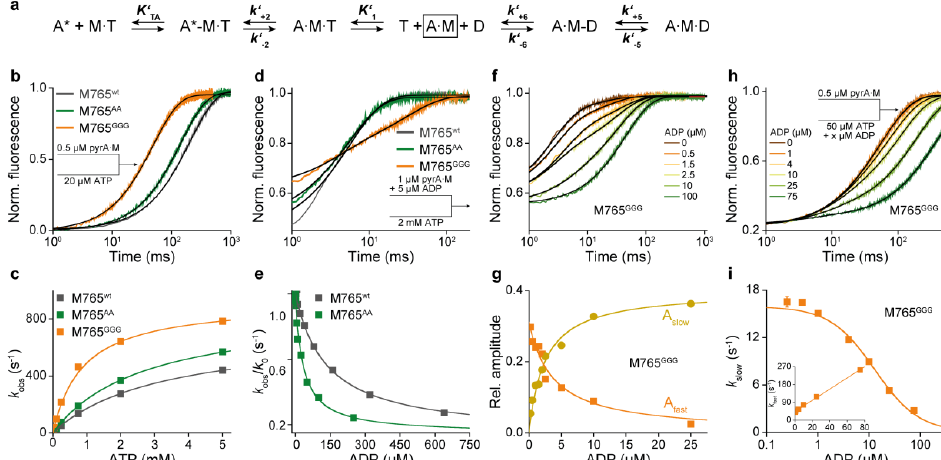
Figure 5. Myosin interactions with nucleotides in the presence of actin. ( a ) Kinetic scheme of the ATP-induced actomyosin dissociation. A*: pyrene-actin fluorescence; A: quenched pyrene-actin fluorescence with bound myosin. ( b ) Normalized fluorescence transients of the dissociation reaction upon mixing a complex of 0.5 µM pyrene-actomyosin (pyrA∙M) with 20 µM ATP. Single exponential fits to the transients yielded concentration-dependent rates ( k obs ) of ATP binding to acto- myosin. ( c ) Second order rate constant of ATP binding to A∙M ( K’ 1 k’ +2 ) and rate of A∙M∙T to A-M∙T isomerization ( k’ +2 ) were obtained from hyperbolic fits of the k obs dependency on ATP. ( d , e ) Affinity of ADP to actomyosin ( K ’ 5 K ’ 6 ) determined by mixing 1 µM pyrA∙M complex in the presence of increasing ADP concentrations with excess ATP. M765 wt and M765 AA displayed monophasic, and M765 GGG biphasic transients shown as exemplary for 2.5 µM ADP ( d ). ( e ) Plots of normalized rate constants ( k obs / k 0 ; with k 0 = dissociation rate constant in the absence of ADP) against ADP concentration. Hyperbolic fits to the data yielded equilibrium dissociation constants of ADP from actomyosin ( K ’ 5 K ’ 6 ). ( f ) For M765 GGG , ATP-induced complex dissociation in the presence of increasing amounts of ADP could be fitted by double exponentials. ( g ) Reciprocal hyperbolic dependency of the relative amplitudes for the fast phase (A fast ) and the slow phase (A slow ) reveal the affinity of ADP for A∙M765 GGG . ( h , i ) Competitive binding of ATP and ADP to A∙M765 GGG . ( h ) Fluorescence transients upon mixing 0.5 µM pyrA∙M with a mixture of 50 µM ATP and increasing concentrations of ADP (0 to 75 µM). Transients were best fit by double exponentials, yielding rate constants for ADP release ( k’ +5 ) from the y-intercept of the hyperbolic fit to the ADP- dependent rates of the slow phase ( i ). Liner fit to the ADP-dependent rate of the fast phase ( i, inset ) yields the second order rate constant of ADP binding to A∙M ( k’ -5 K’ 6 ).